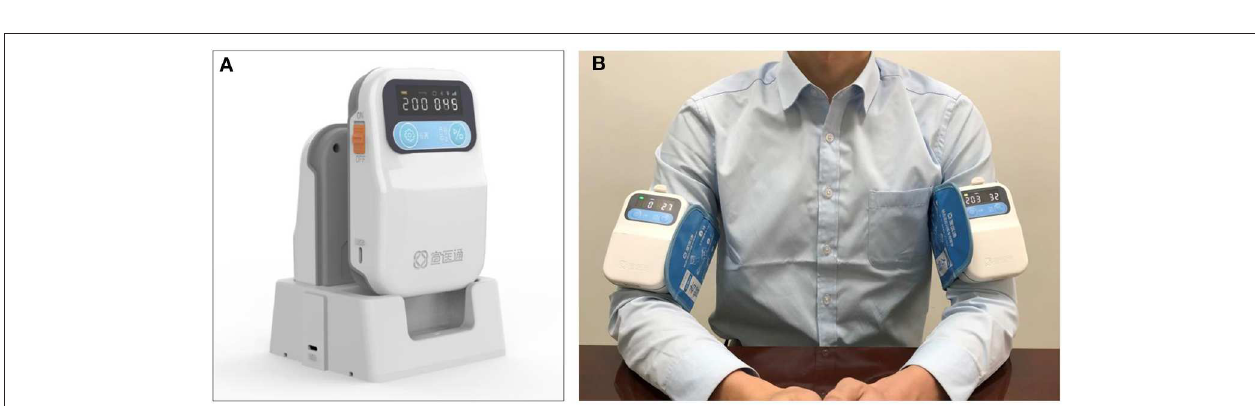
FIGURE 1 | Trial design flowchart. ICH, intracerebral hemorrhage; GCS, Glasgow Coma Scale score; RIC, remote ischemic conditioning; NIHSS, National Institutes of Health Stroke Scale; mRS, modified Rankin Scale; CT, computed tomography.